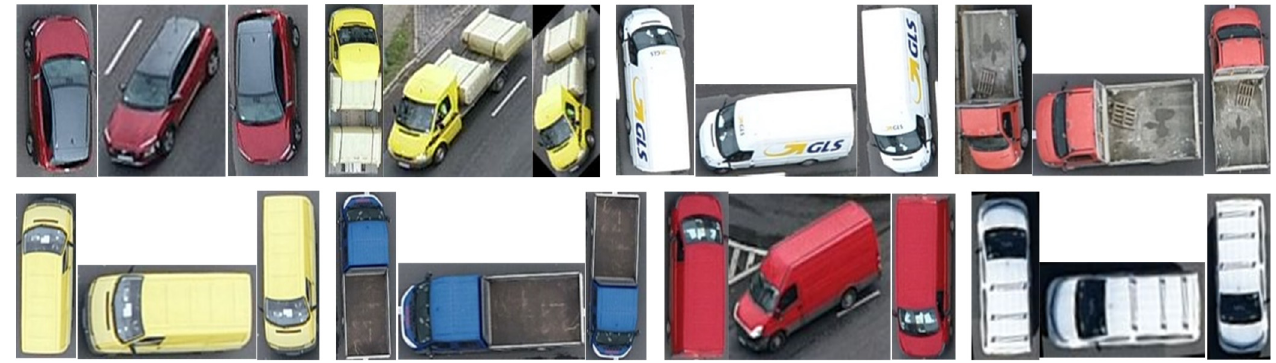
Figure 5. Sample images for automatic detection of a vehicle moving between two cameras.